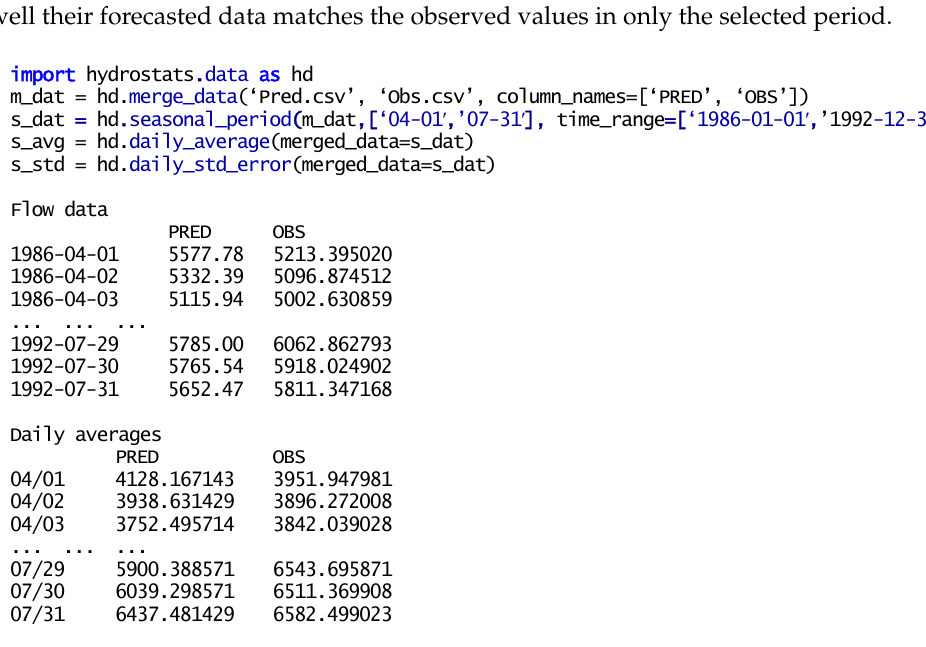
Figure 2. Presents an example of code and results. The code loads two .csv files into a single data object with named columns (line 1), then extracts the data from April 1 to July 31 from the period January 1, 1986 through December 31, 1994. Below the code are the first and last three lines of the merged data frame, m_dat, and the daily average, s_avg , data frame. We do not show the data from the standard deviation data frame, s_std .